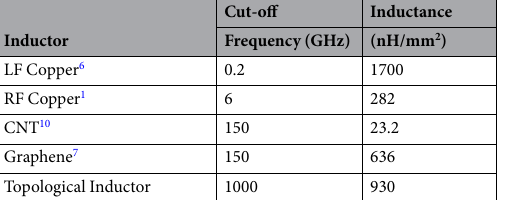
Table 1. Comparison of modern inductor performance. Low-frequency (LF) copper-based inductors provide a large inductance due to their low resistance, but this performance is limited below one GHz due to the